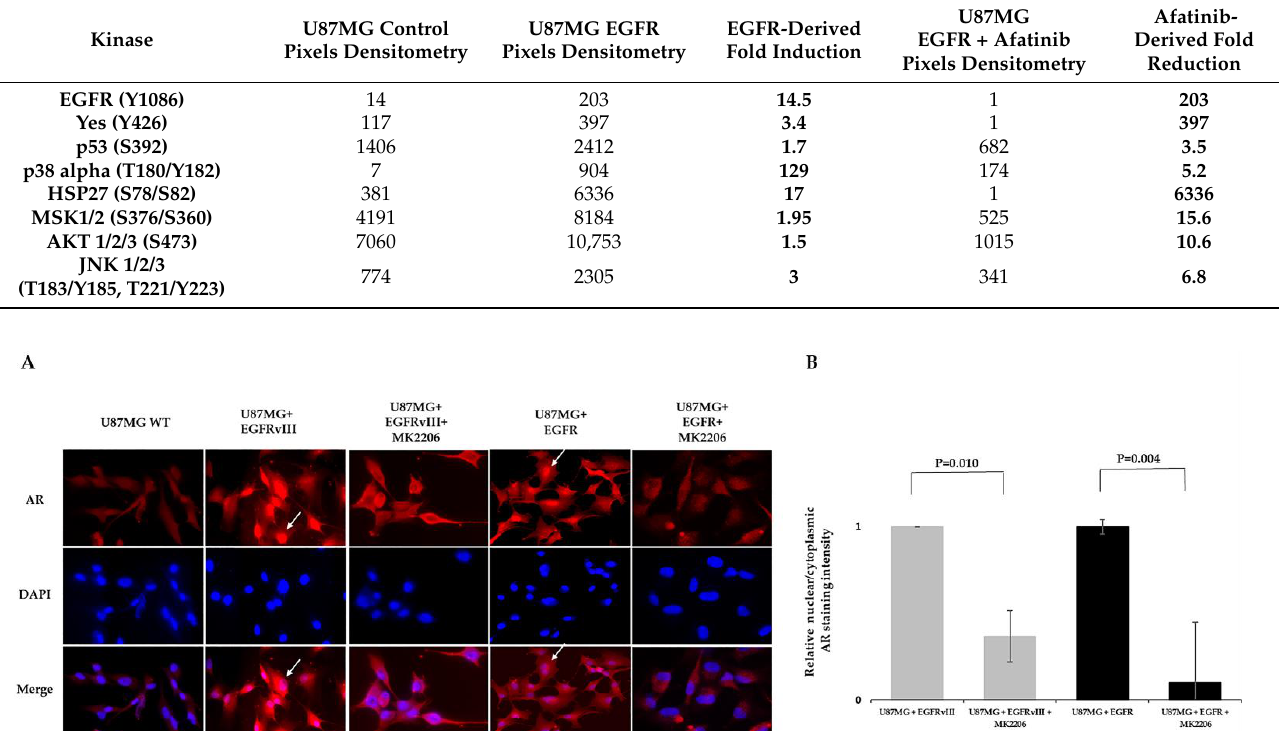
Table 1. The kinases with high fold phosphorylation levels in response to overexpression of EGFR that were decreased following afatinib treatment.